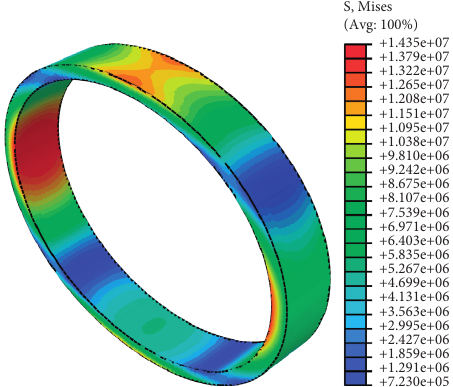
Figure 8: Average Mises stress cloud.